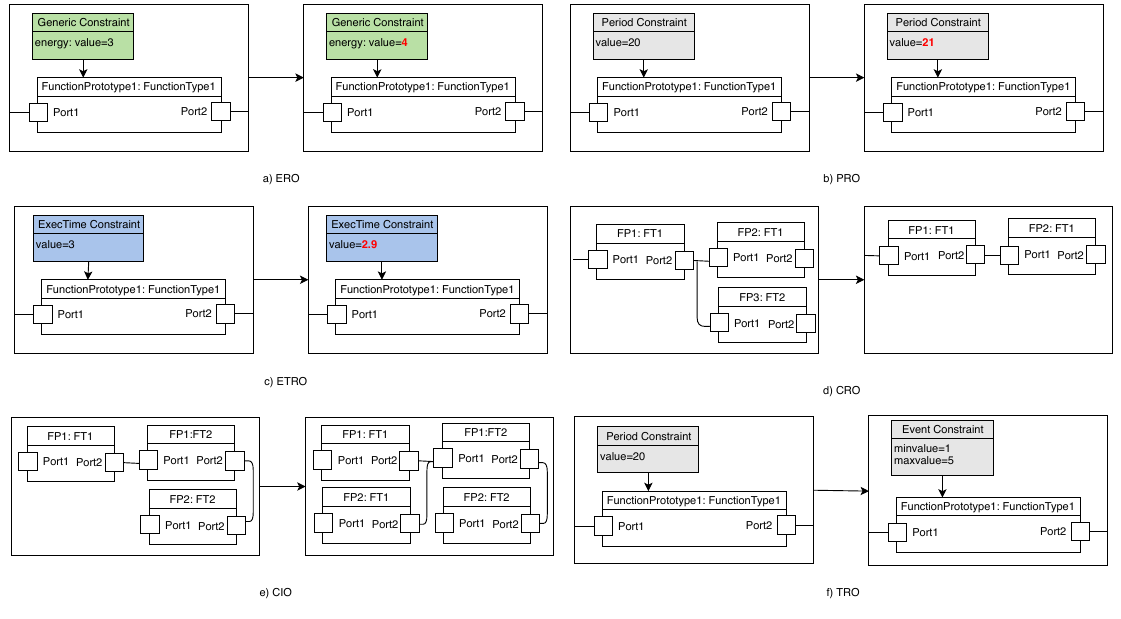
Figure 2. Examples of mutations for each mutation operator for EAST-ADL architectural models.